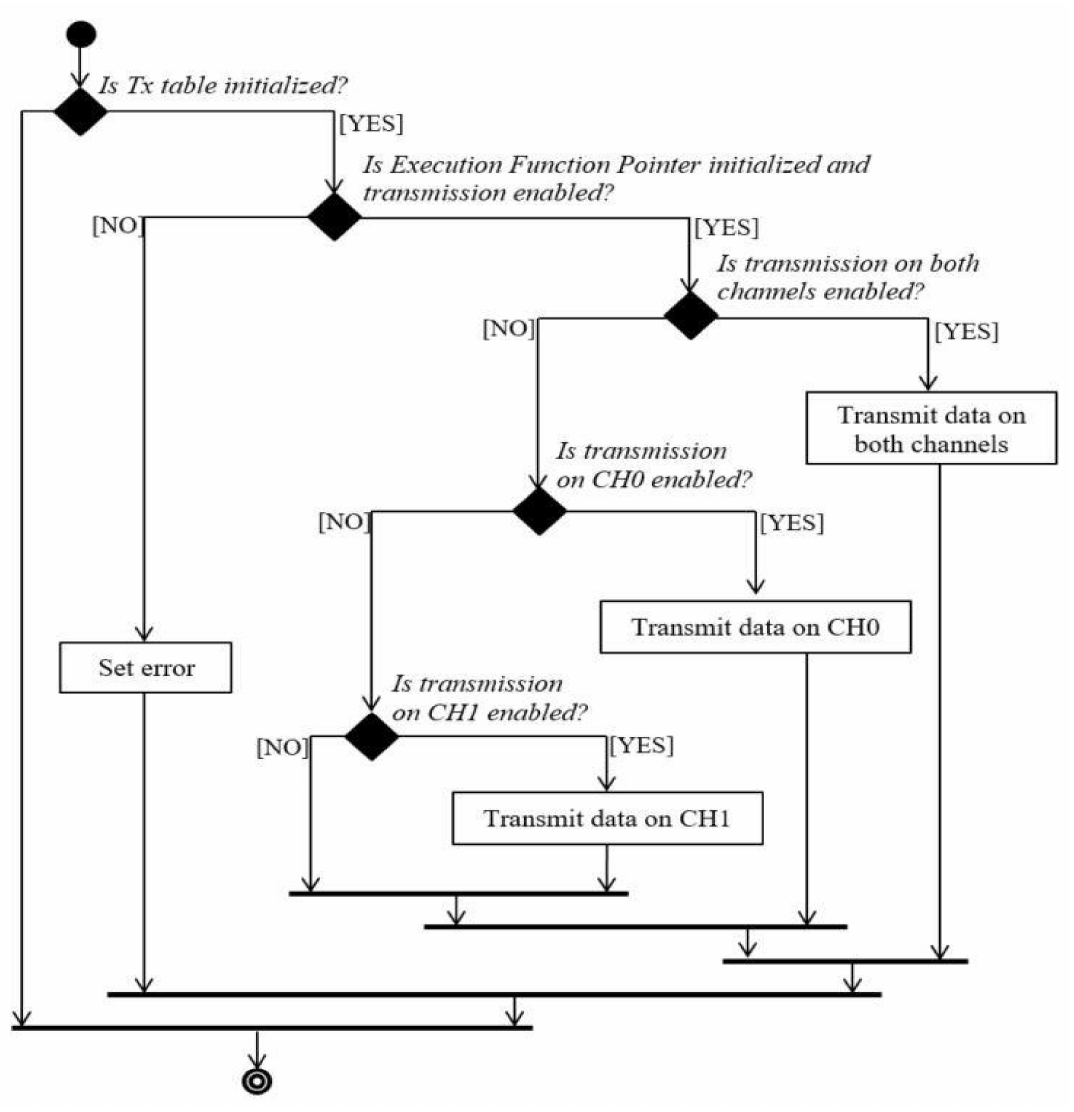
Figure 8. Transmission configuration